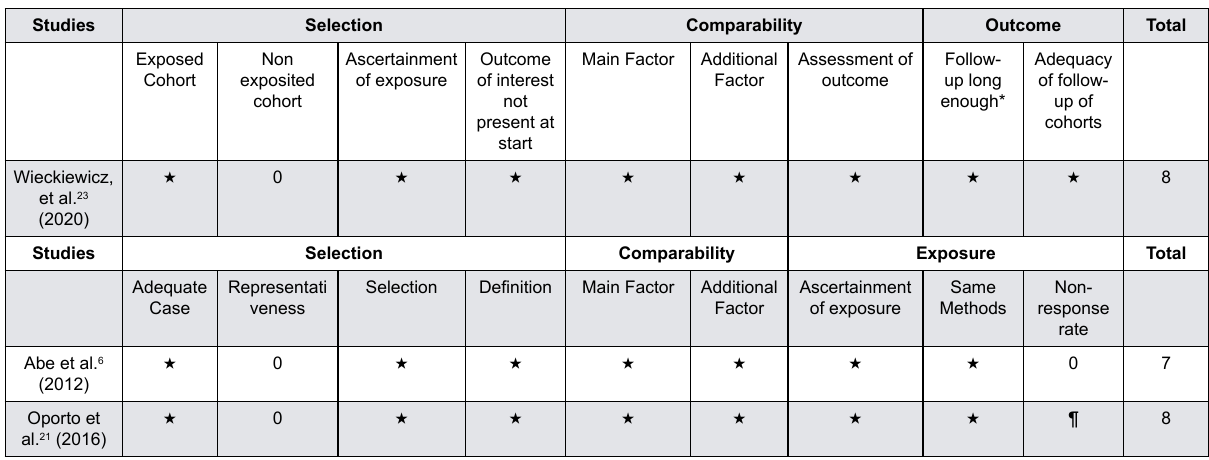
Figure 4- Assessment quality of Non-RCT included studies based on New Castle Ottawa